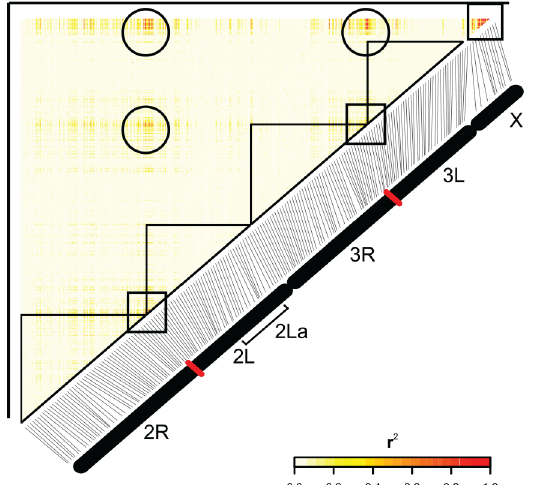
Fig 5. Signals of population differentiation between A . gambiae and A . coluzzii . We screened for genome-wide linkage disequilibrium (LD) outside the centromeric Speciation Islands (SI). The individual SNP that is the most informative for the observed genome-wide disequilibrium between A . coluzzii and A . gambiae is position X.23852135, located within the X-chromosome SI (see Methods). This SNP was tested for LD with all other genome wide SNPs at an r 2 > 0.5, minor allele frequency (cid:3) 10%. The plot indicates SNPs highly correlated with X.23852135 under these parameters. 66 SNPs outside of centromeric SI met selection and quality criteria as new candidate markers of subgroup/sister taxa differentiation (S2 Table). Circles highlight linkage patterns across chromosomes, while squares indicate the high-LD centromeric regions of each